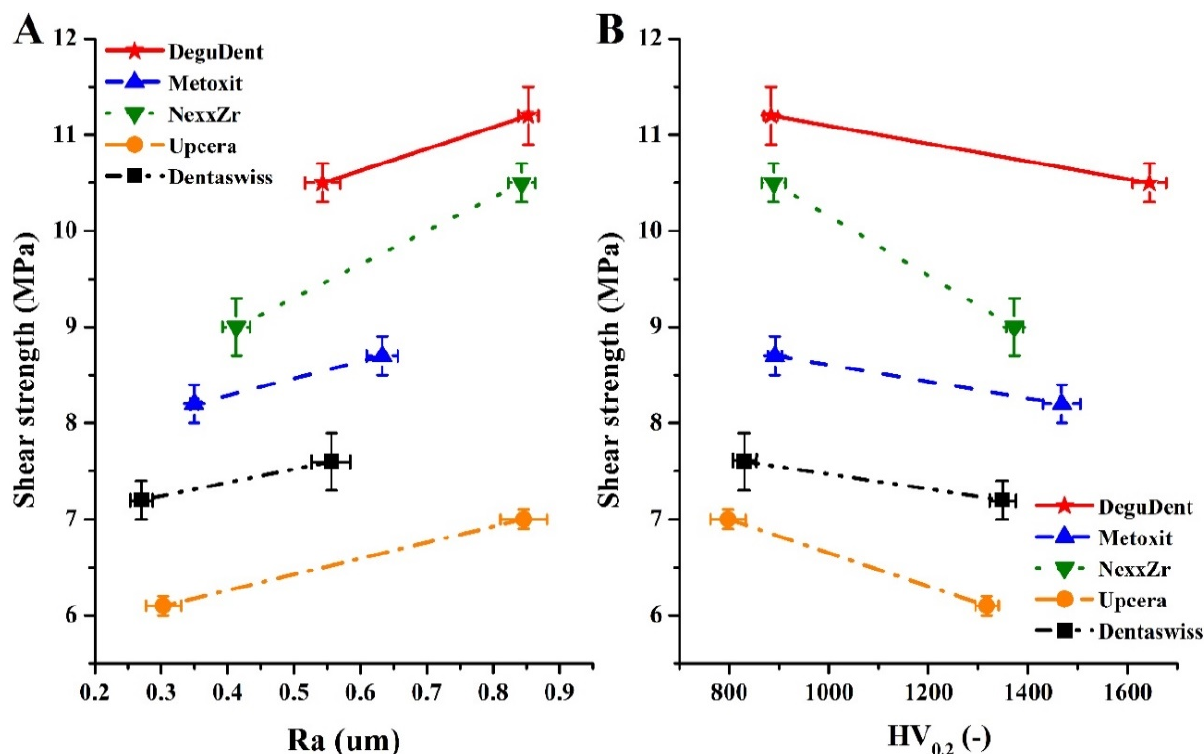
Figure 9. The bond strength between different zirconia samples and teeth after the aging test ( p < 0.05, mean ± SD, n = 4): ( A ) Comparison of shear strength and average roughness; ( B ) Comparison of shear strength and Vickers hardness (−).